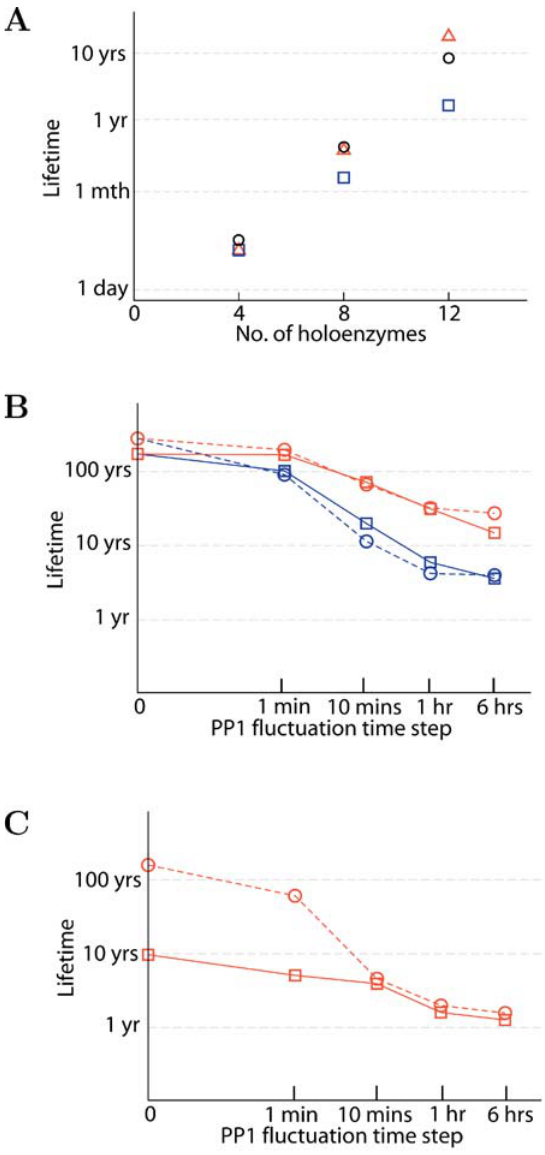
Figure 5. Switch Stability in the Presence of Spontaneous Fluctuations in Free Calcium Concentration and the Total Number of Enzymes (A) Effect of Ca 2 þ fluctuations on stability (lifetime) as a function of number of CaMKII holoenzymes. Circles indicate the original system without Ca 2 þ fluctuations. Squares indicate the original system with free Ca 2 þ fluctuations of amplitude 0.1 l M and baseline 0.07 l M. Triangles indicate adjusted system with free Ca 2 þ fluctuations of amplitude 1.0 l M and baseline 0.1 l M. The adjusted system has alternativeparameters,suchthat N PP 1 = N CaMK /2, k 1 =6s (cid:1) 1 , k 2 =7s (cid:1) 1 , and K H 1 = 4.0 l M. The ordinate is in logarithmic scale. (B) Effect of fluctuations in the number of PP1 molecules on the lifetime of UP states (squares/solid line) and DOWN states (circles/ dashed line) (16 holoenzymes). The timescale on the abcissa is the average time for the number of PP1 molecules to increase or decrease by one. Red indicates 12 , N PP 1 , 20. Blue indicates 8 , N PP 1 , 24. The ordinate is in logarithmic scale. (C) Lifetime of UP states (squares/solid line) and DOWN states (circles/ dashed line) when the number of holoenzymes and PP1 molecules fluctuate in the respective ranges 14 , N CaMK , 18 and 8 , N PP 1 , 24. The timescale for PP1 fluctuations varies along the abcissa. The timescale for CaMKII fluctuations is fixed by the turnover rate (30 h per holoenzyme). The ordinate is in logarithmic scale. DOI: